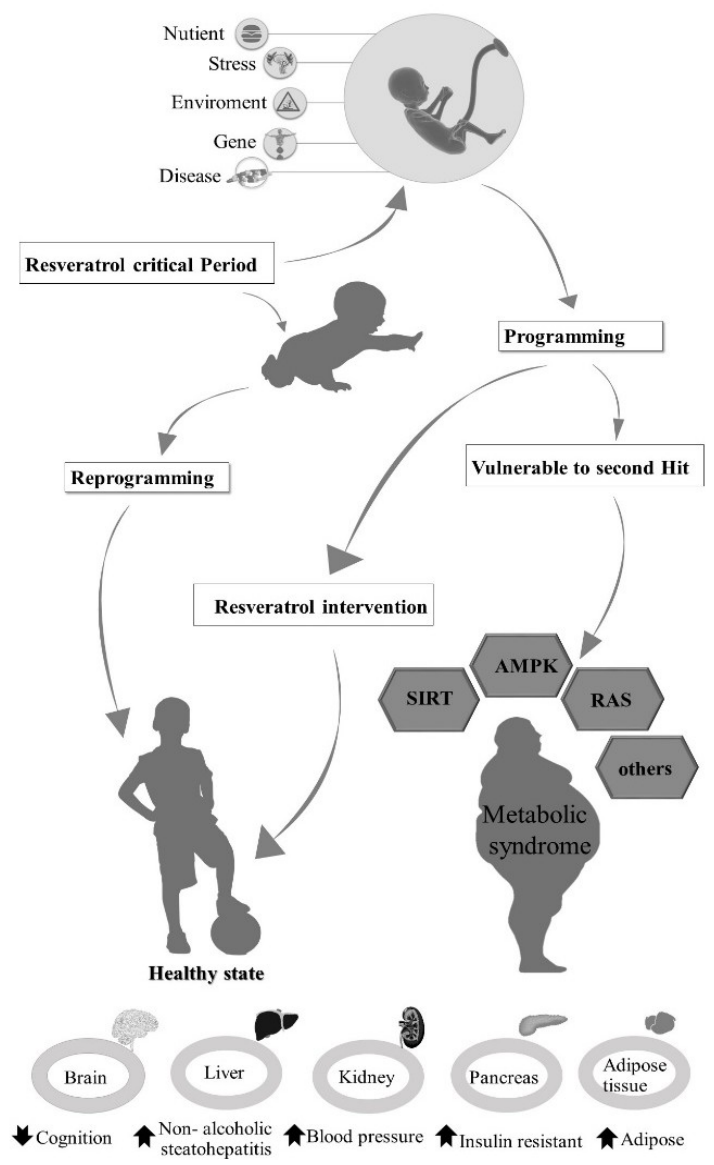
Figure 2. The role of resveratrol in metabolic syndrome.